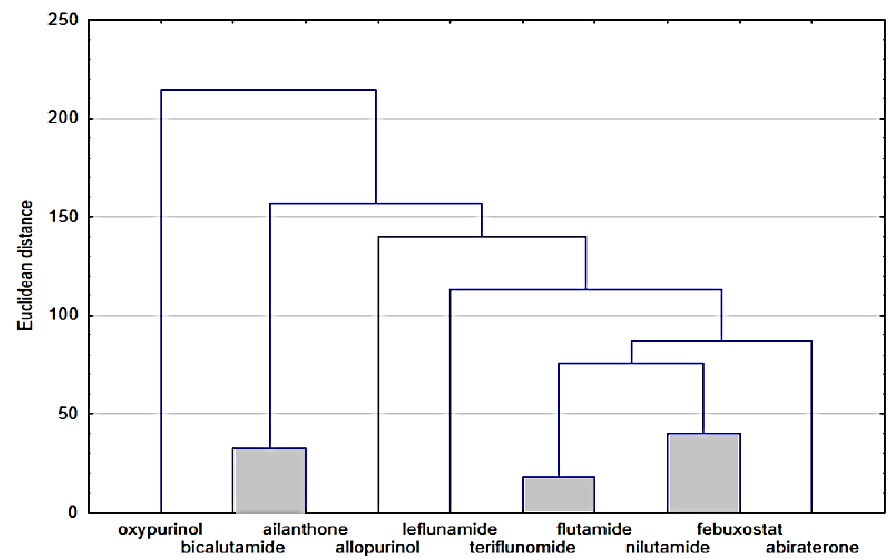
Figure 4. Analysis of similarities of studied compounds based on the analysis of all data regarding both lipophilicity and physicochemical properties.